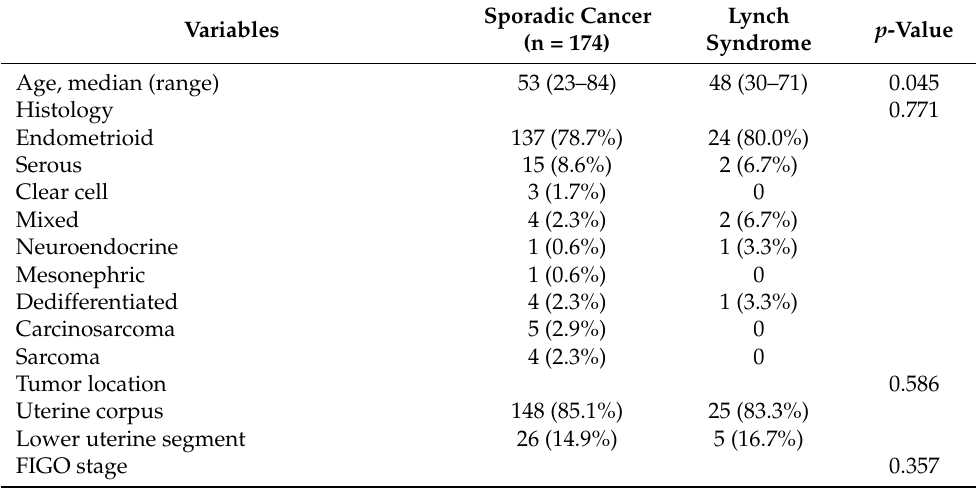
Table 3. Comparison of patients with Lynch Syndrome and sporadic endometrial